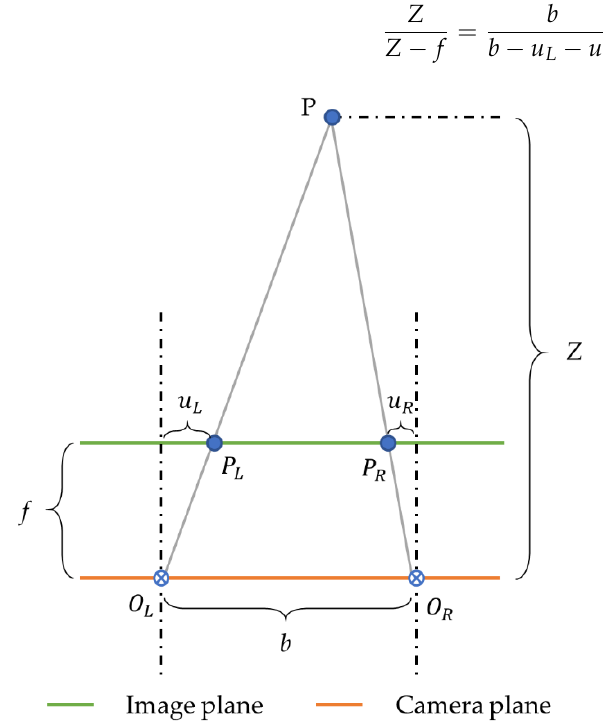
Figure 6. The geometric model of the binocular system. f is the focal length, b is the baseline distance of the binocular stereo vision system, and 𝑍 is the distance from the point to the camera.